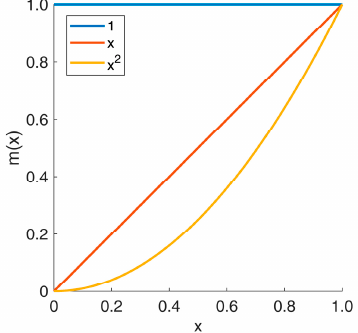
Figure 1. Monomial basis functions for a parabola in the interval [0, 1].